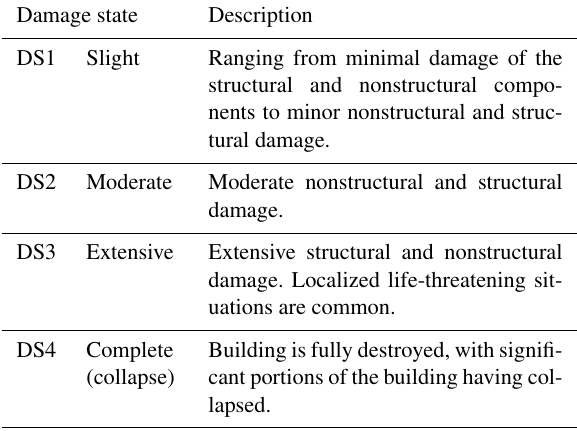
Table 3. Description of seismic damage state (HAZUS, 2003; Rosetto and Elnashai,